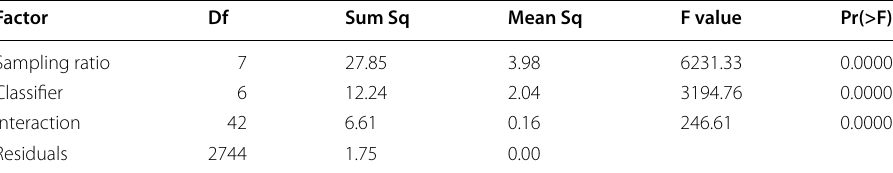
Table 10 ANOVA results for 2-factor test of classifier and sampling ratio with Brute Force web attacks, including their interaction; in terms of AUC Factor